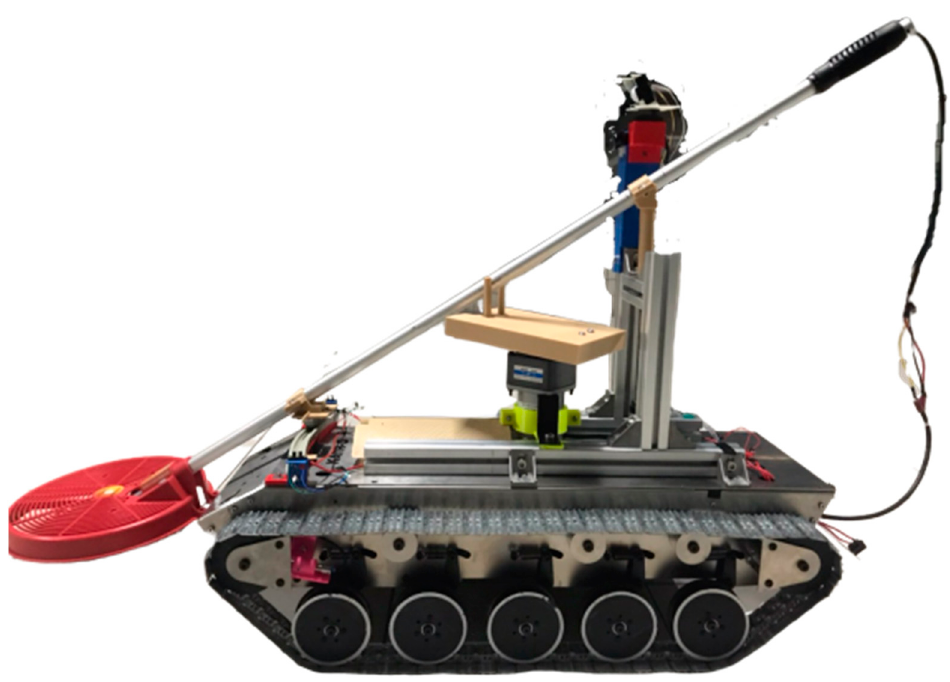
Figure 19. The finished product of the automatic robotic lawn mower.